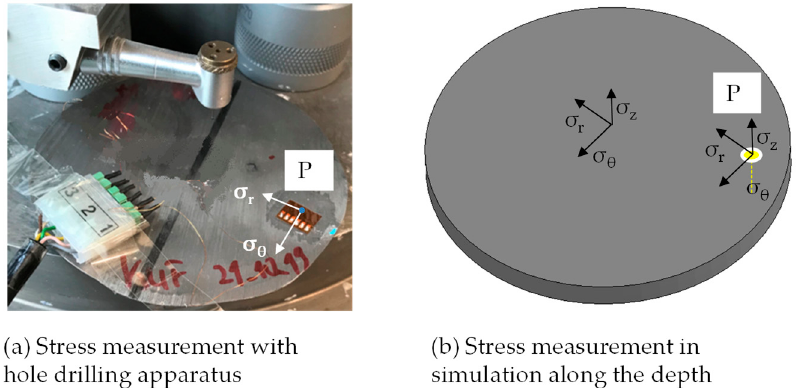
Figure 18. Position of the residual stress measurement point in hole drilling experiment ( a ) and numerical analysis ( b ).